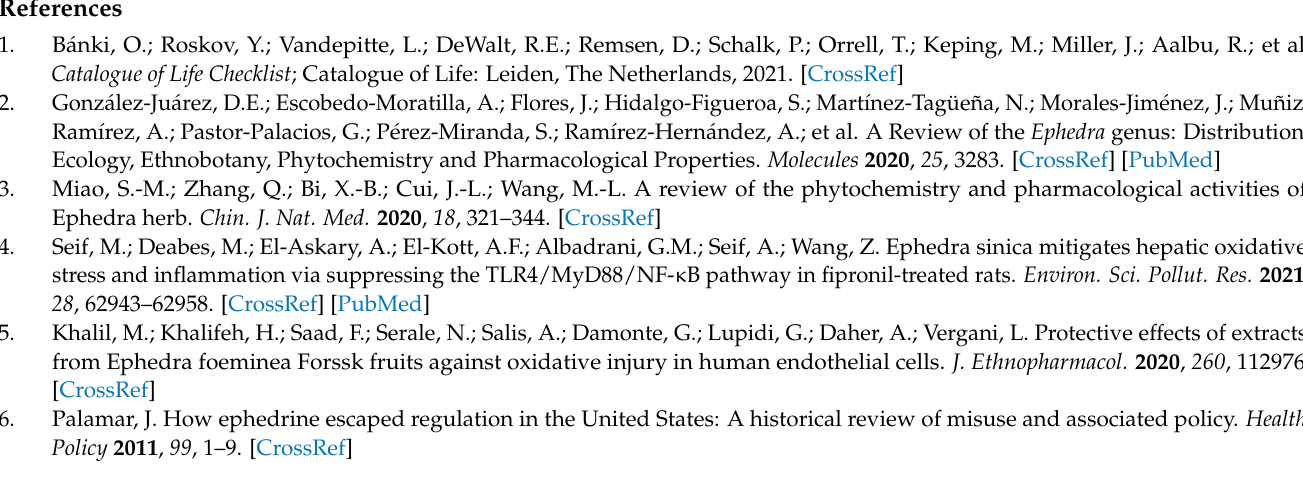
S1; Figure S2: BLAST results in NCBI of the sequence S2; Figure S3: BLAST results in NCBI of the sequence S3; Figure S4: BLAST results in NCBI of the sequence S4; Figure S5: BLAST results in NCBI of the sequence S5; Figure S6: BLAST results in NCBI of the sequence S7; Figure S7: BLAST results in NCBI of the nucleotide signature of Ephedra